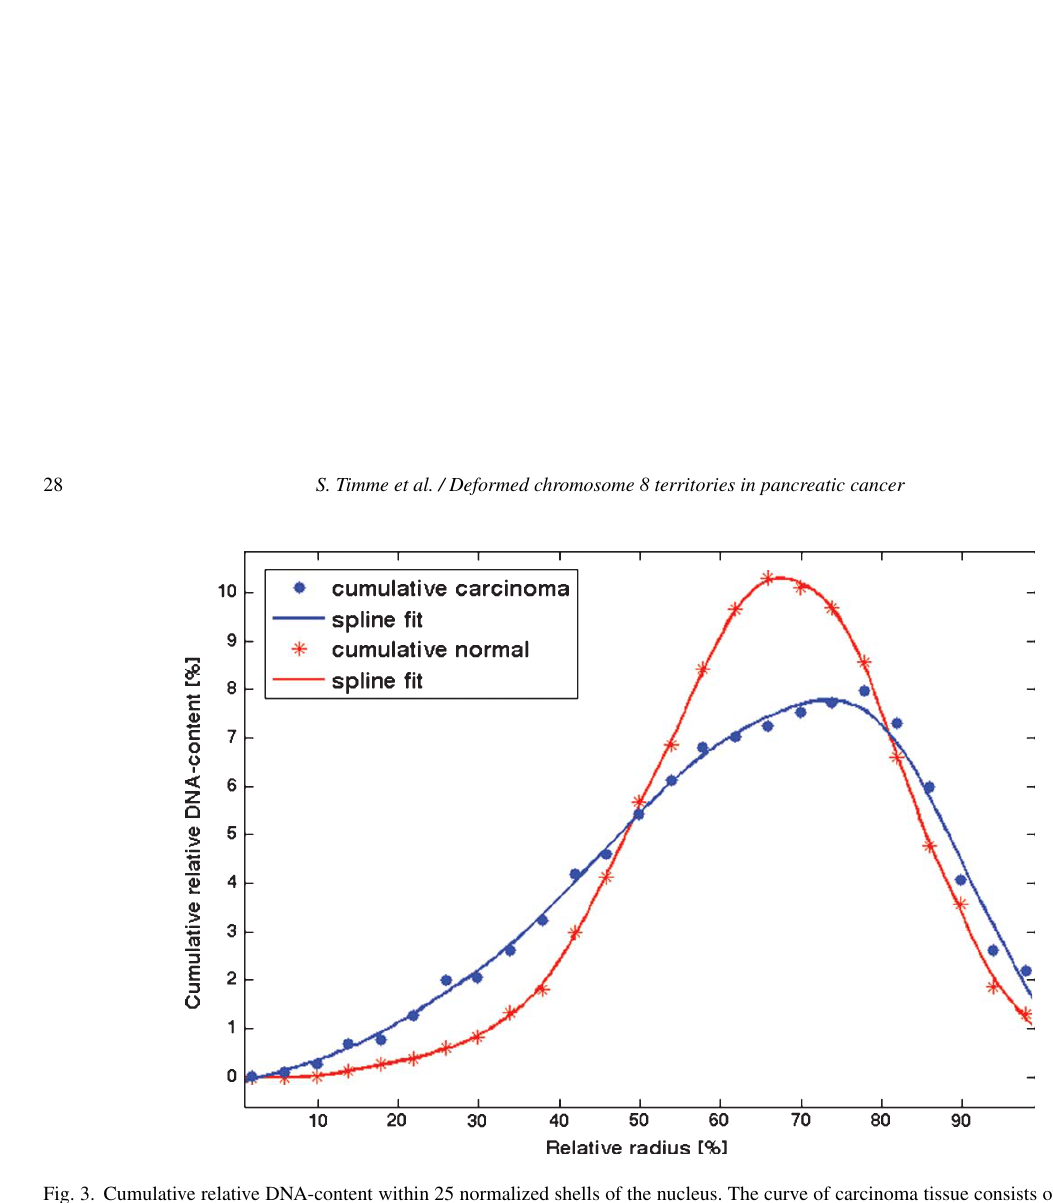
Fig. 3. Cumulative relative DNA-content within 25 normalized shells of the nucleus. The curve of carcinoma tissue consists of the average of 5 patients, the normal curve of the average of 4 patients.